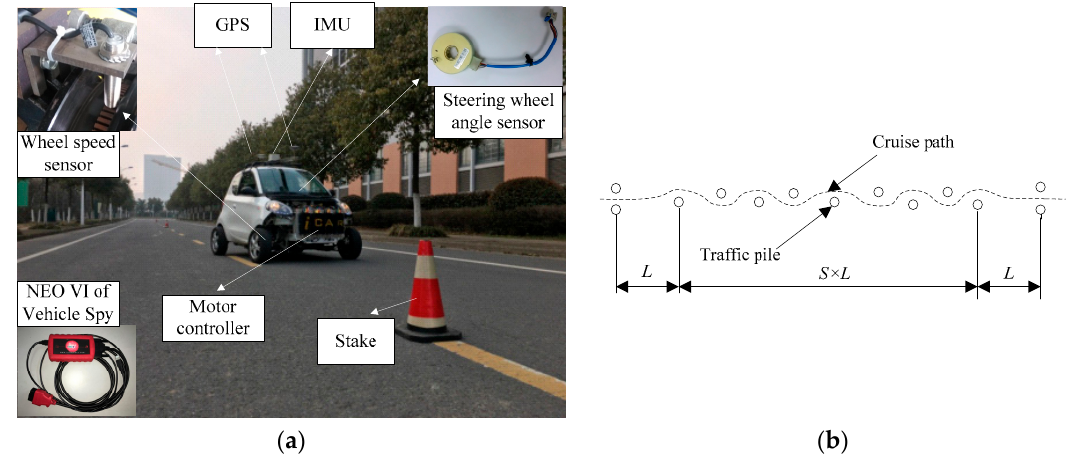
Figure 6. Vehicle road test: ( a ) Refitted vehicle; ( b ) experimental trajectory.